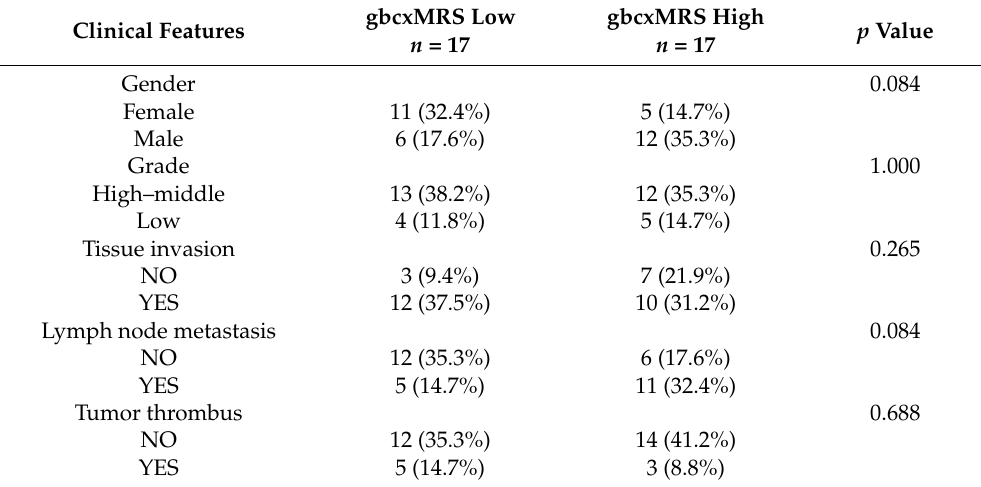
Table 2. Comparison of clinical features between high and low gbcxMRS groups in the FUSCC